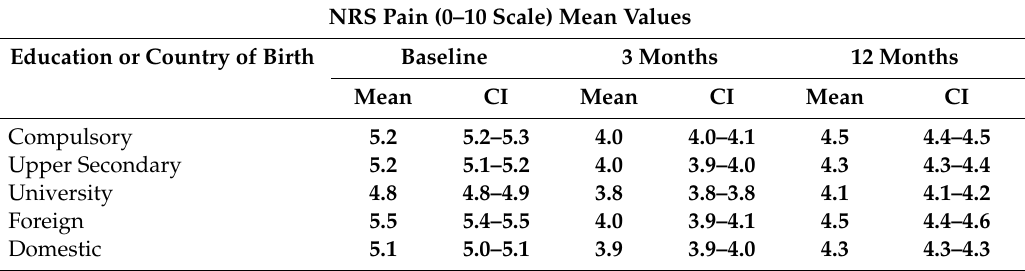
Table 4. Adjusted outcomes for variables related to pain, HRQoL, willingness to undergo joint surgery and mobility ( n =